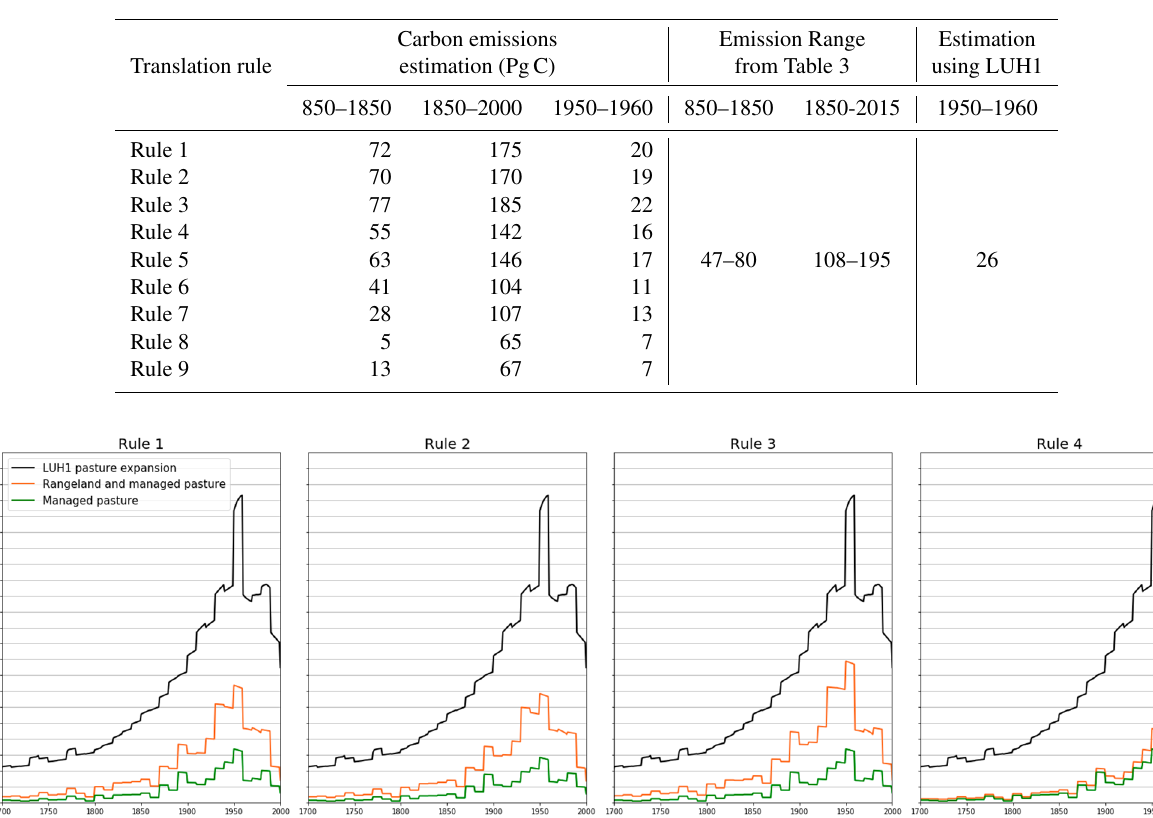
Table 5. Summary of LULCC carbon emissions estimated by the nine translation rules and those from other studies in Table 3.